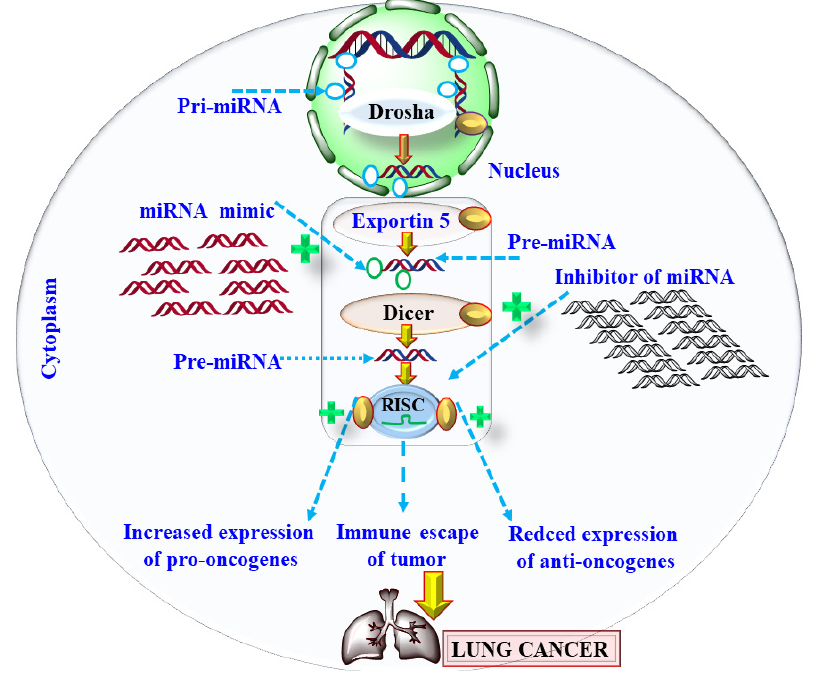
Figure 5. Showing the biosynthesis and the role of miRNA in lung cancer.